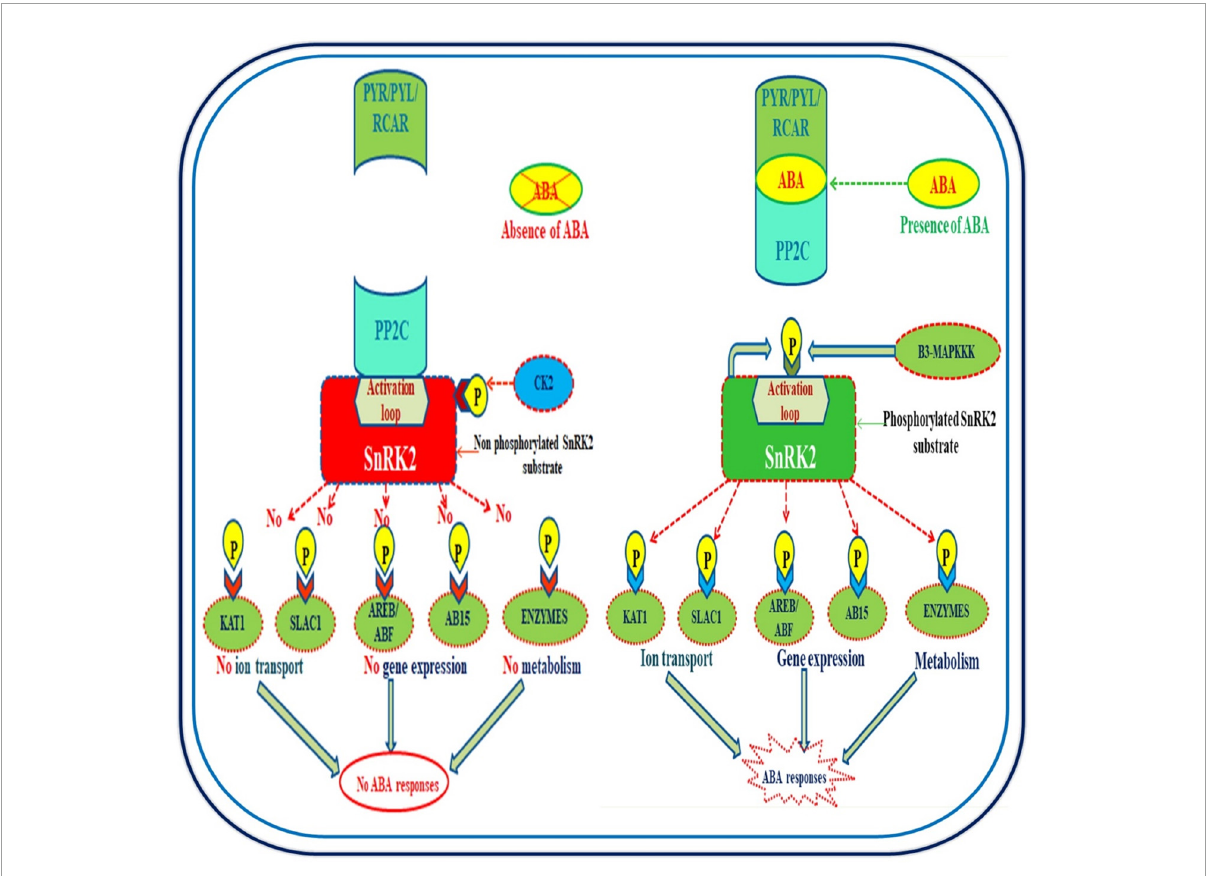
FIGURE2 Schematic representation of the mechanism of action of abscisic acid (ABA). The core component of ABA signaling includes pyrabactin resistance 1 (PYR1)/PYR-Like (PYL), regulatory component of ABA receptors (RCARs), clade a protein phosphatases PP2C, ABA insensitive 1/2 ABI 1/2, hypersensitive to ABA1/2, HBA1/2, and sucrose non-fermenting-1-related protein kinase 2 family members